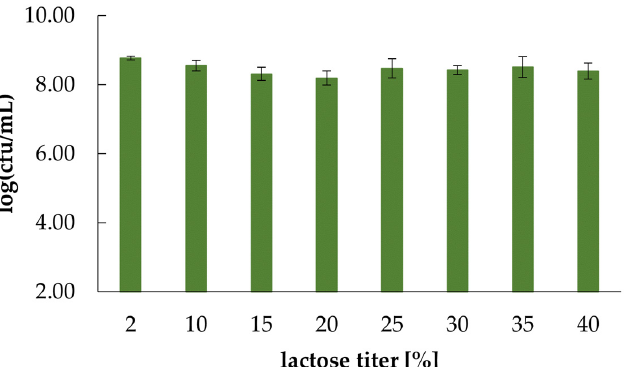
Figure 5. The results of the tolerance test for increasing concentrations of lactose (2–40% ( w / v )). Cells were grown overnight in a SAB medium and thereafter serially diluted to 10 − 7 . 10 µL samples of 10 0 –10 − 7 dilutions were spread on YNB-lactose medium in four repetitions and incubated at 30 °C for 48 h. Colonies were examined, and cfu/mL was calculated according to Equation (9).